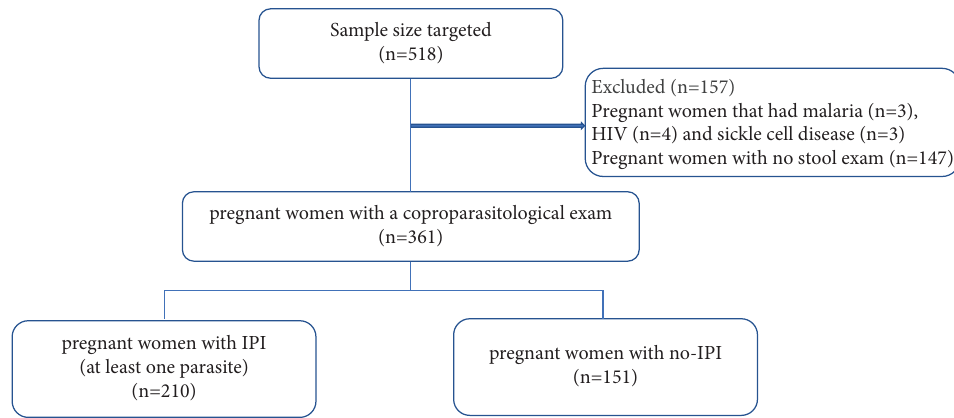
Figure 1: Flowchart of participation in the